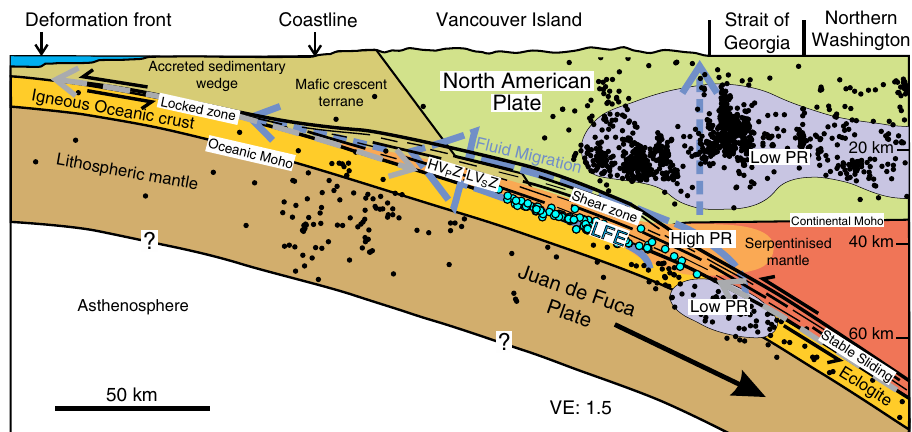
Fig. 6 Migration and trapping of metamorphic fl uids in shear zone above dehydrating Juan de Fuca plate. Dehydration of the subducting plate, including that due to transformation of basalt to eclogite, is associated with in-slab seismicity at >40 km depth. The onset of seismicity corresponds to a zone of lower Poisson ’ s ratio in the slab, which lies below an extensive region at the tip of the mantle wedge where seismic velocities and elevated Poisson ’ s ratio (PR) are consistent with partially serpentinized peridotite. In the case of plate boundary Model 1, rising fl uids are trapped within the shear zone above the subducting plate and may migrate seaward (blue dashed arrows), with local escape possible in regions of higher vertical permeability. In the case of Model 2, fl uids are also generated in the shear zone by dehydration of upper oceanic crust stripped from the downgoing slab. In both cases, high pore pressures and high Poisson ’ s ratio occur within the lower part of the shear zone, but pore pressures fall where slab-derived fl uids escape through the mantle wedge, landward of the downdip termination of the low-frequency earthquakes (LFEs) and electrical conductor (vertical dashed blue arrow). The shear zone between the mantle wedge and the subducting plate can include fragments of oceanic crust, eroded forearc and/or rocks of the mantle wedge. HV P Z high P wave velocity zone, LV S Z low S wave velocity zone, LFEs — fi lled blue circles, earthquakes — fi lled black